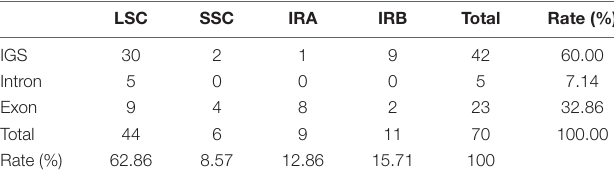
TABLE 5 | Characteristics of the divergence hotspot